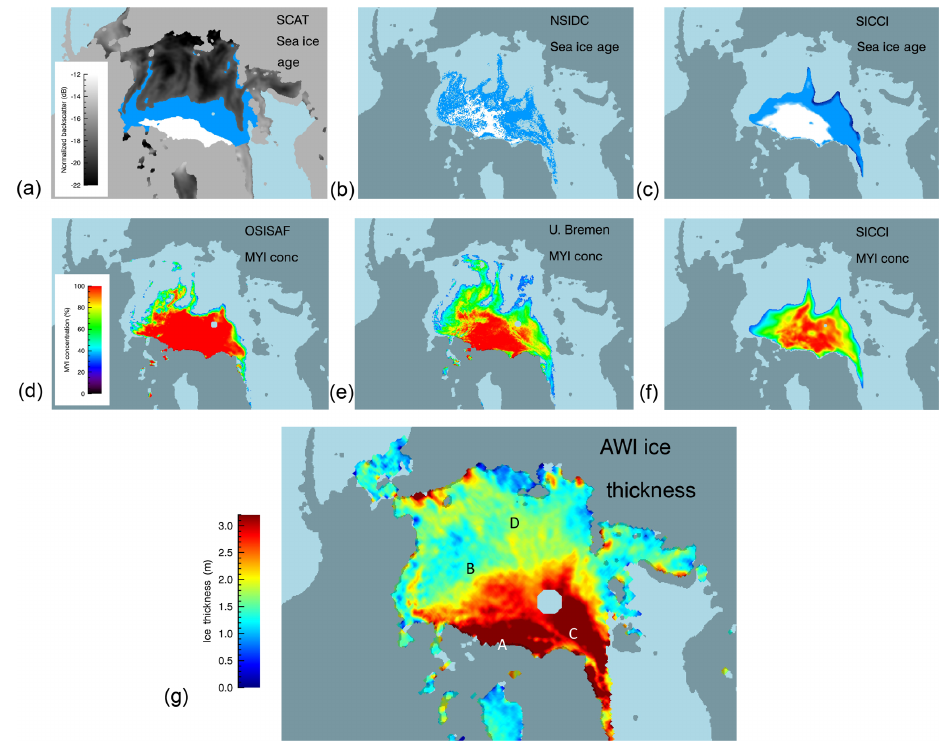
Figure 13. Different observation-based products for the representation of multiyear ice in March 2016. (a–c) Sea ice age (light blue is SY ice, white is old MY ice): (a) is from the scatterometer record, (b) is the NSIDC sea ice age and (c) is from the SICCI algorithm. (d–f) Multiyear ice concentration (MY > 30%): (d) from the OSI SAF-403, (e) the University of Bremen algorithm and (f) the SICCI algorithm. (g) Sea ice thickness. See text for